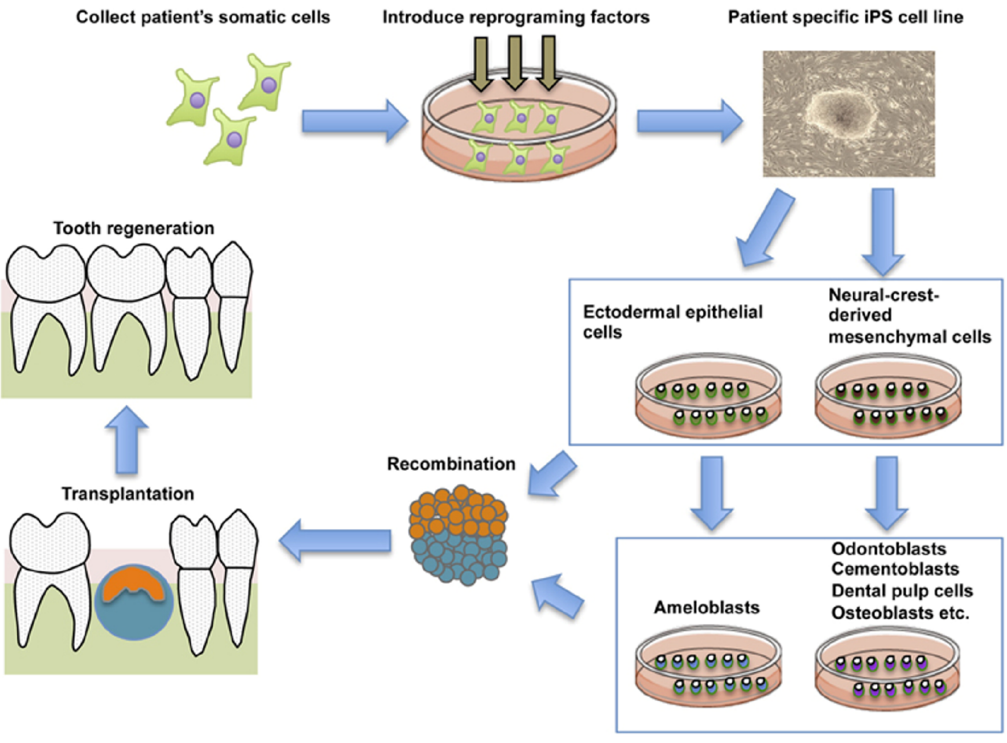
Figure 4. General schematic representation of the current strategy for whole tooth regeneration using iPSs. The patient’s somatic cells are harvested. Reprogramming conditions/factors are introduced to induce self-renewal and pluripotency, and patient-specific iPSCs are established. iPSCs are induced to form ectodermal epithelial cells and neural crest-derived mesenchymal cells, and they are further induced to form odontogenic cells in vitro . The two cell populations are combined by direct contact, mimicking the in vitro arrangement. Interaction of these cells leads to formation of a nearly-stage tooth germ. Once transplanted into the mouth, the recombinants develop and lead to functional recovery from tooth loss. This figure is reproduced from Otsu et al. [148] under open-access license